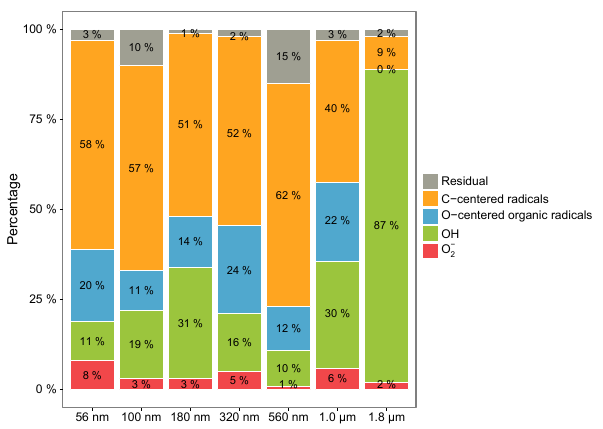
Figure 5. Relative amount of ROS in atmospheric aerosol impactor samples with lower cut-off diameters in the range of 50nm–1.8µm (Mainz, Germany; 26–27 June 2015) are as follows: O − (green), carbon-centered (orange), oxygen-centered organic radi- cals (blue) and residual (unidentified,